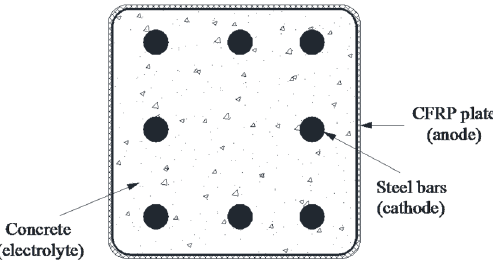
Figure 7. An eight-steel rebar-reinforced concrete element wrapped with CFRP plate as an Figure 7. An eight ‐ steel rebar ‐ reinforced concrete element wrapped with CFRP plate as an anode.